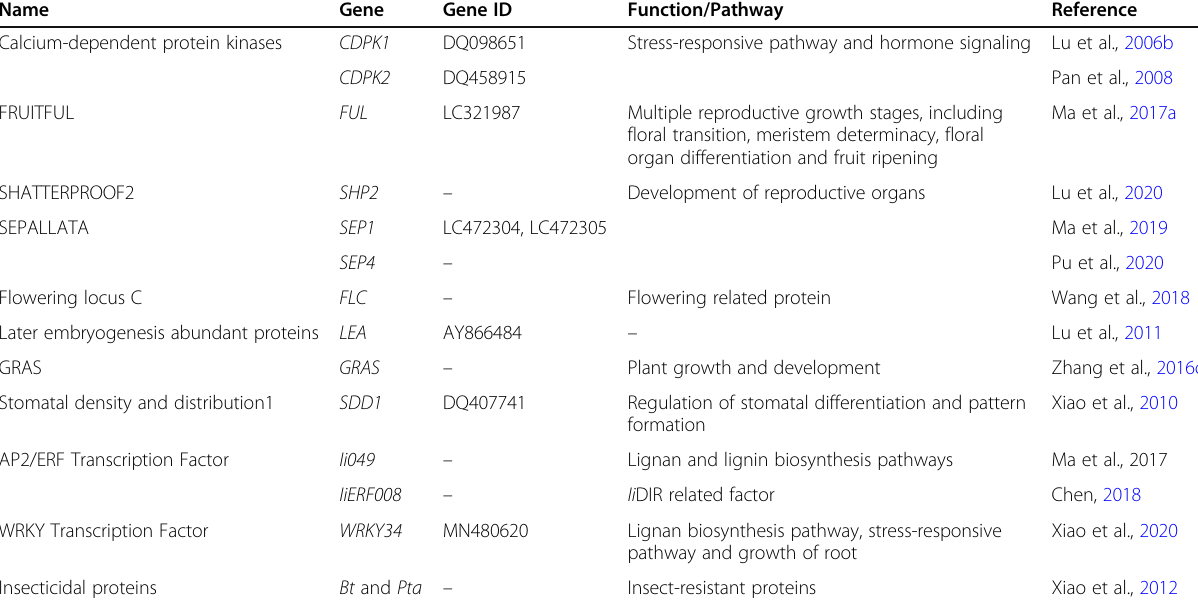
Table 2 Regulatory genes used for genetic improvement of I.